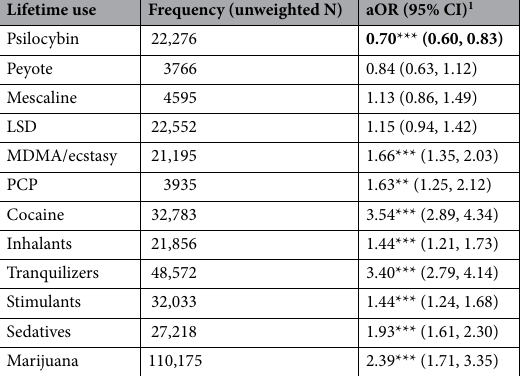
Table 2. Associations between lifetime use of various substances and opioid use disorder (OUD). 1 *p < 0.05;